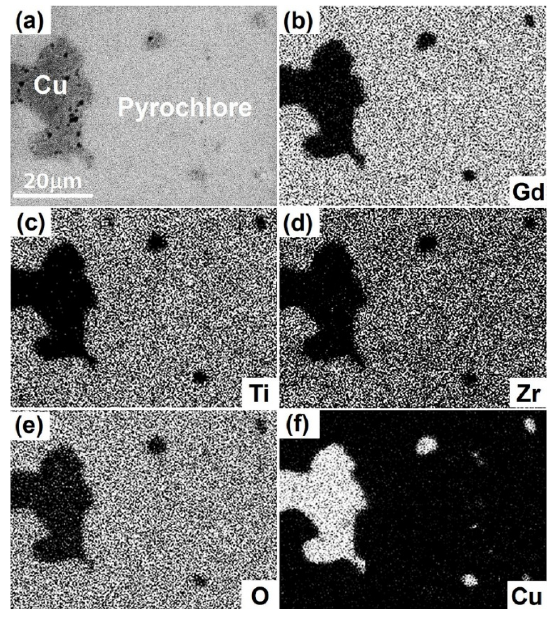
Fig. 6 EDX mapping images of consolidated Zr-35 specimen with pressure time 26 s: (a) representative BSE image of the matrix and elemental mapping images of (b) Gd, (c) Ti, (d) Zr, (e) O, and (f) Cu.